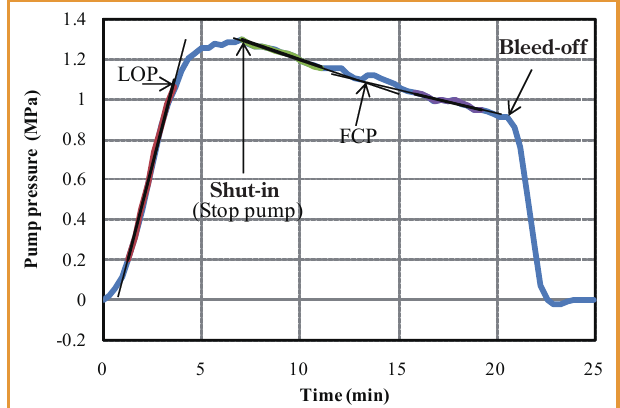
Figure 3. Pumping pressure at drilling rig level versus elapsed time during XLOT carried out on board the riser vessel Chikyu .